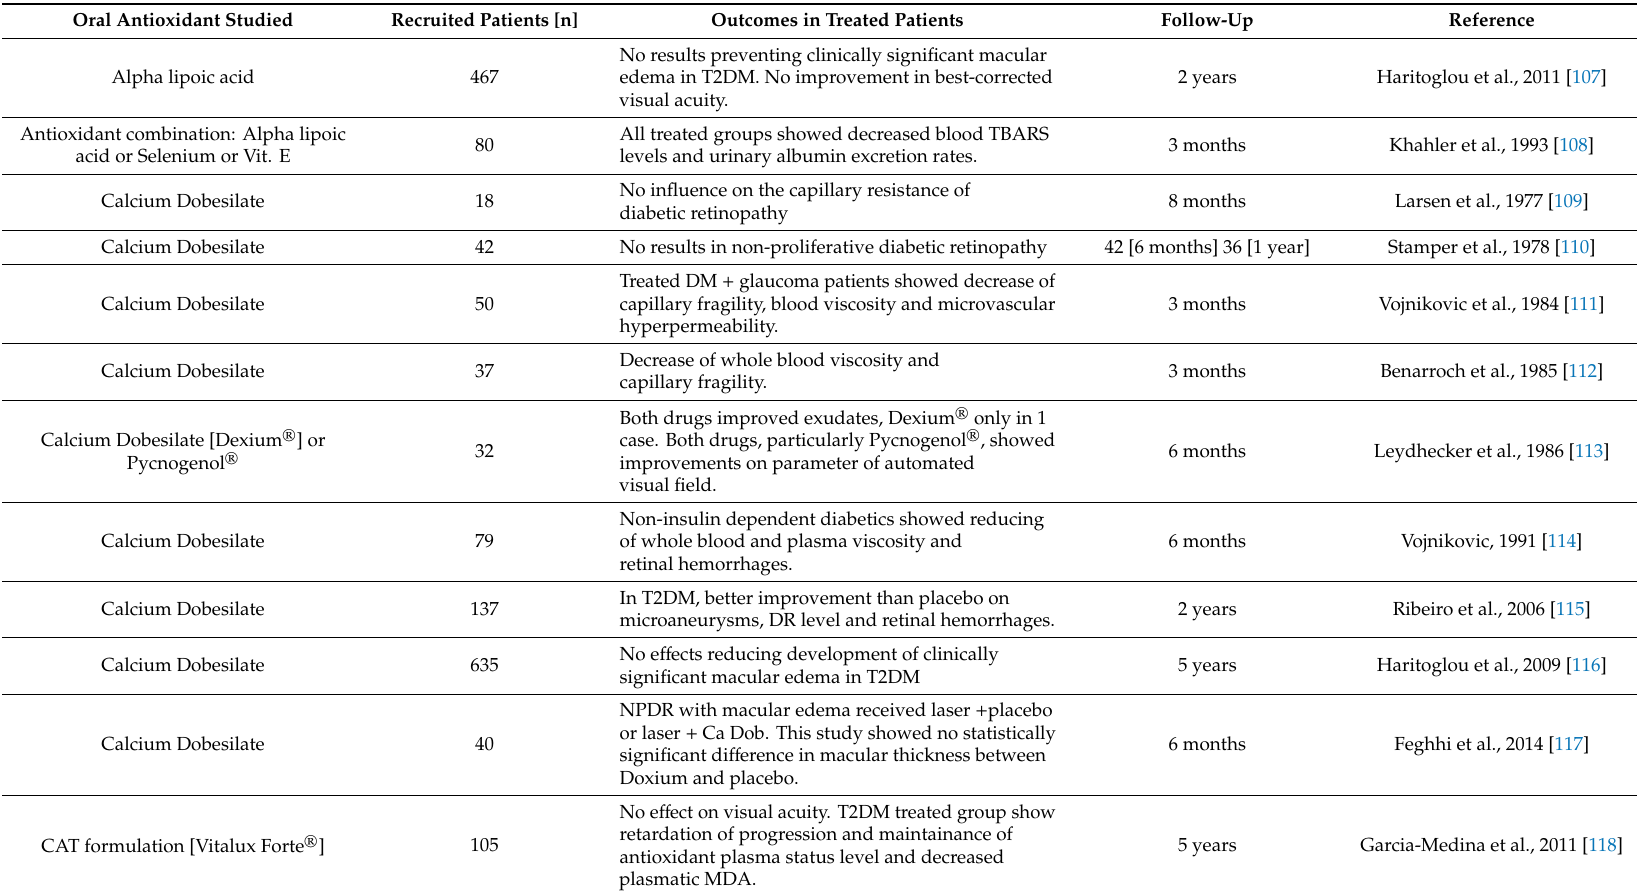
Table 3. Results of human studies. CAT = combined antioxidant